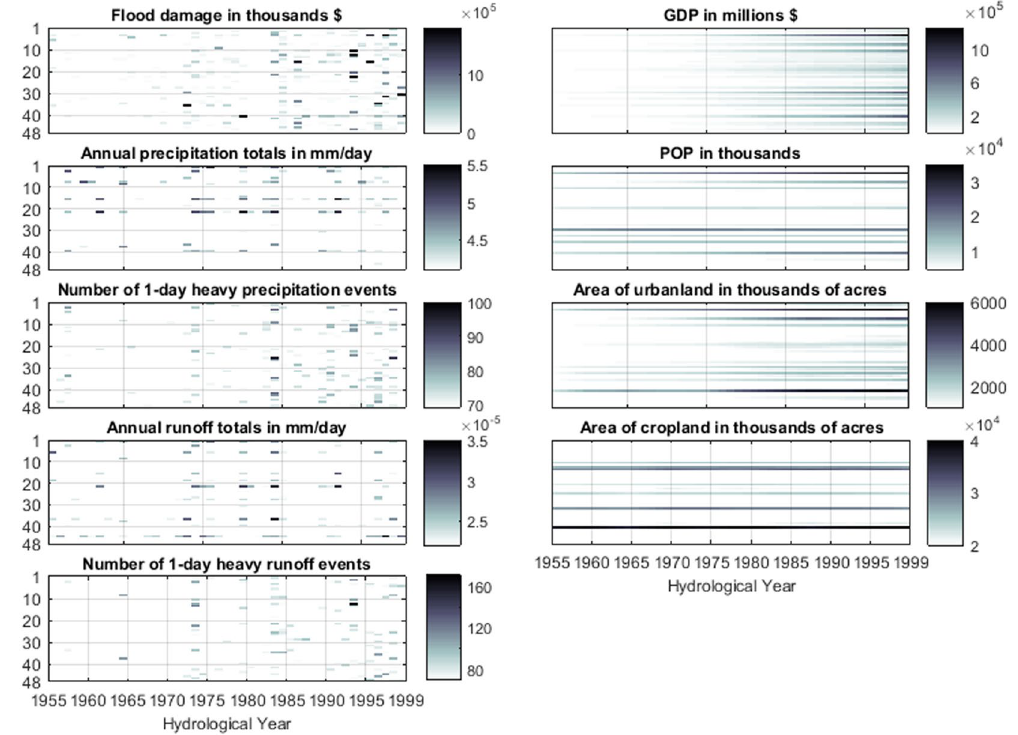
Figure 3. Temporal changes in flood damage and the corresponding hazard and social-economic factors in 48 investigated states during 1955–99. The y-axis indicate the state ID with the location shown in Fig. 2b. Figure was created using software MATLAB 2015a